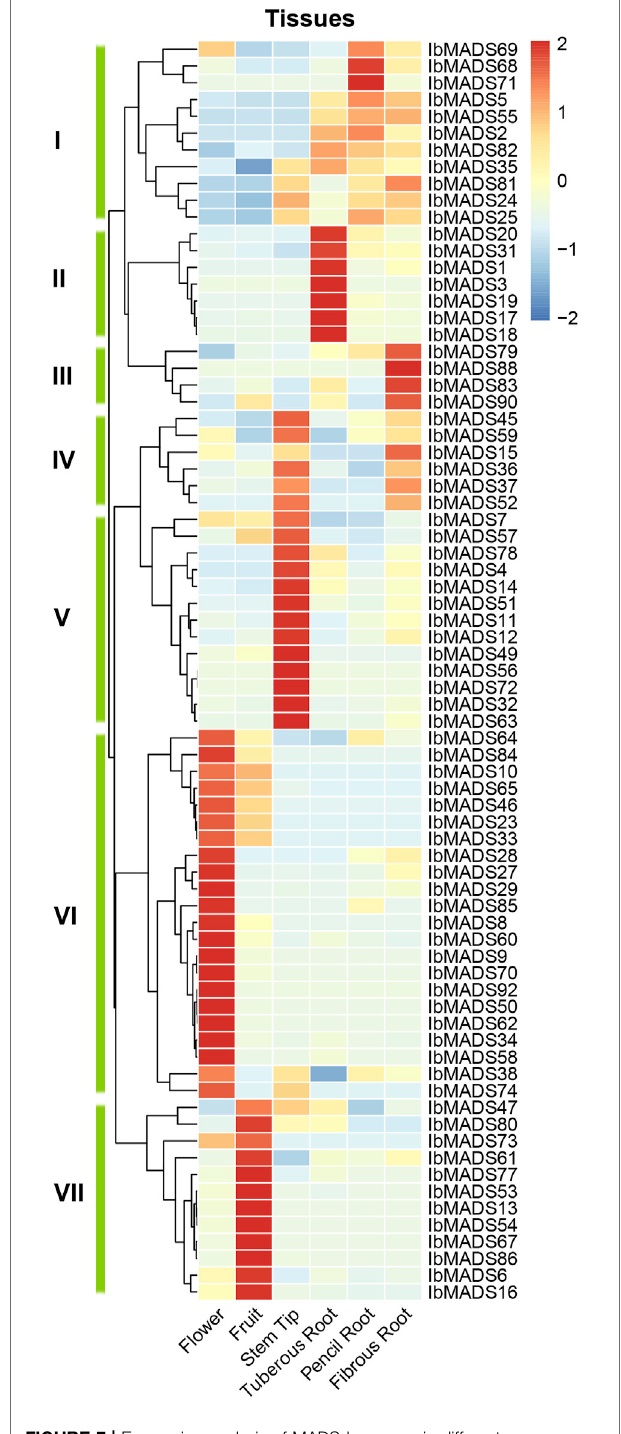
FIGURE 7 | Expression analysis of MADS-box gene in different organisms of sweet potato.